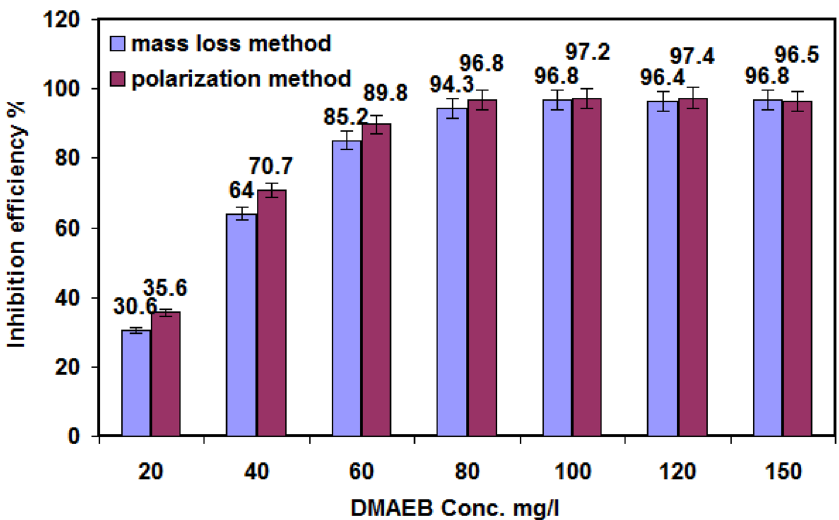
Figure 4. Comparison of inhibition efficiency% values obtained from mass loss and polarization